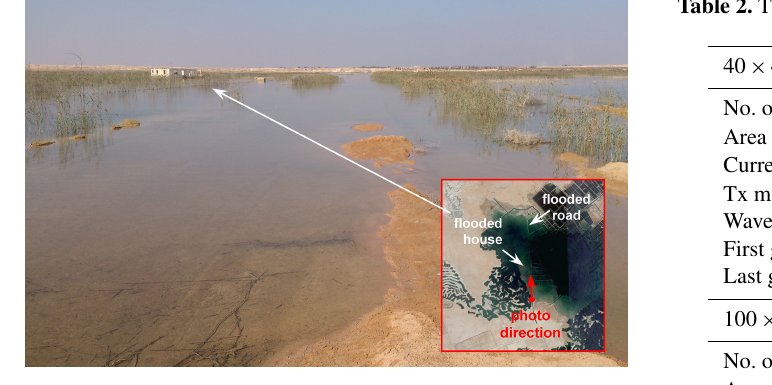
Figure 4. A photo of the Nubariya pond dated November 2013 showing houses and a road abandoned due to the pond expansion. The photo location and direction are shown in the inset.